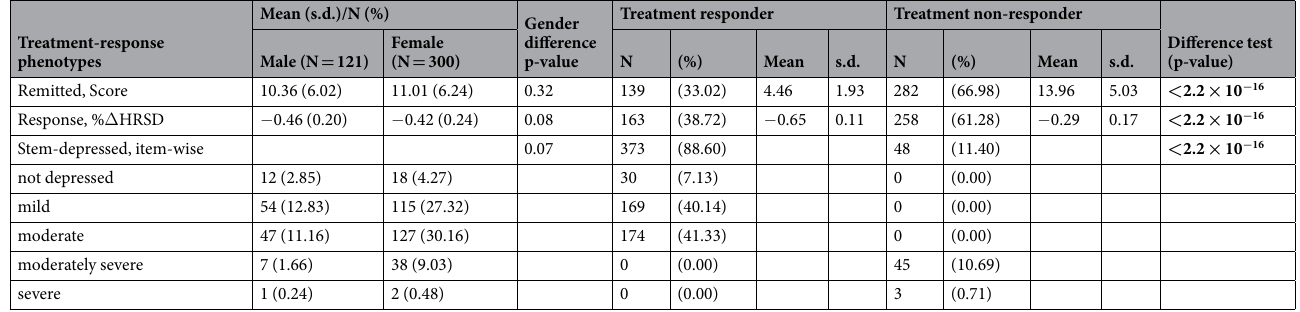
Table 2. Summary statistics for treatment-response phenotypes. a Analyses were based on 421 MDD subjects. b Difference tests were conducted using Student t -test (for continuous data) or Chi-square test (for categorical